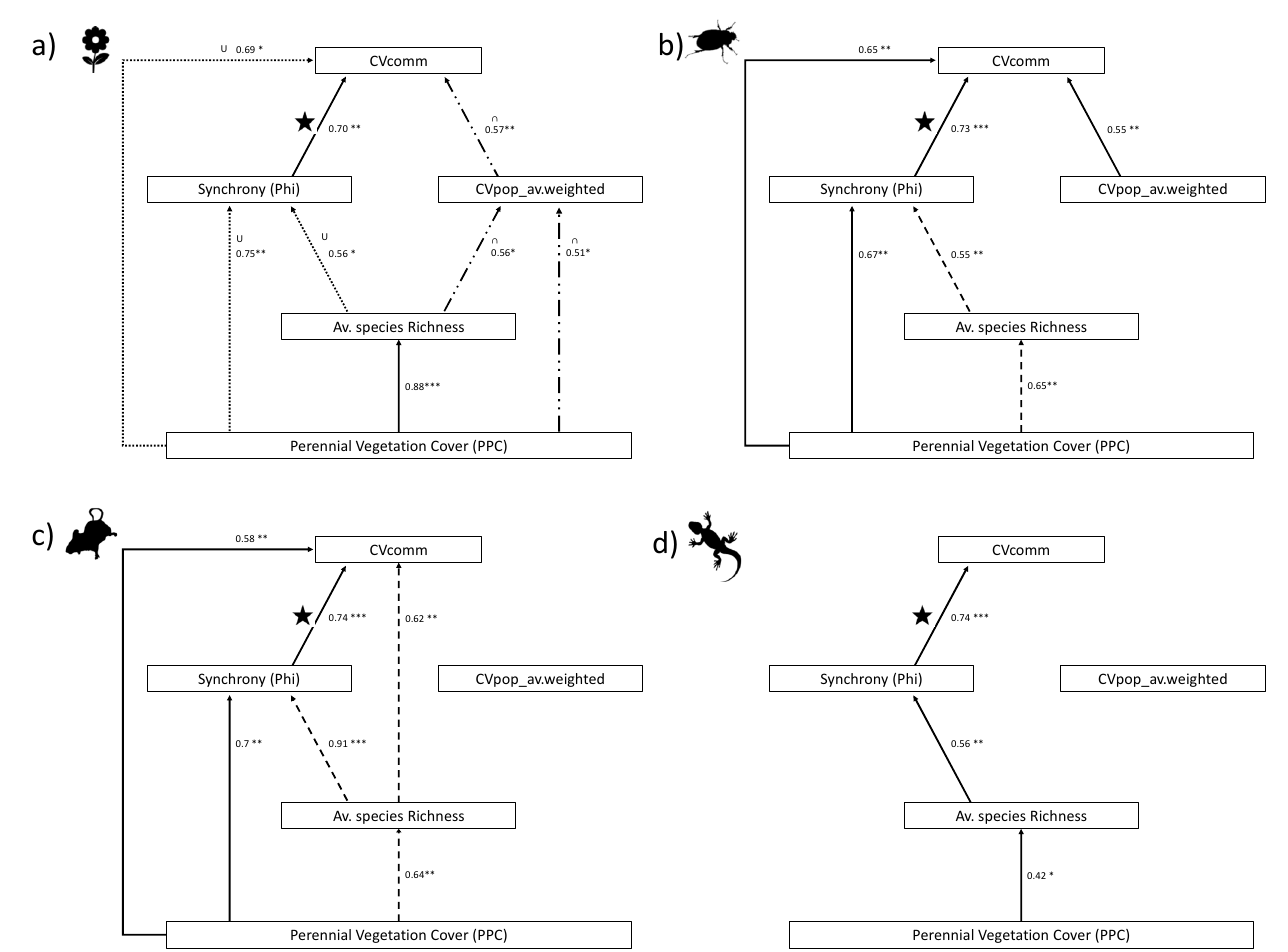
Figure 4. Linear regressions lm(Y~X 2 ) for ( a ) annual plants, and lm(Y~X) for ( b ) beetles ( c ) rodents and ( d ) reptiles. Arrows are drawn from independent (X) to dependent (Y) for all significant regressions (* p < 0.05, ** p < 0.01, *** p < 0.001); Adjusted R 2 values are given and patterns depict directions of correlation: Solid = positive-linear, dashed= negative-linear, dotted = U shaped unimodal, double-dashed = bell-shaped unimodal. Full regression outputs are given in Supplementary Materials Table S2. (cid:70) Depicts the strongest (highest R 2 ) positive correlation for each taxon and is presented in full in Figure 3e–h.